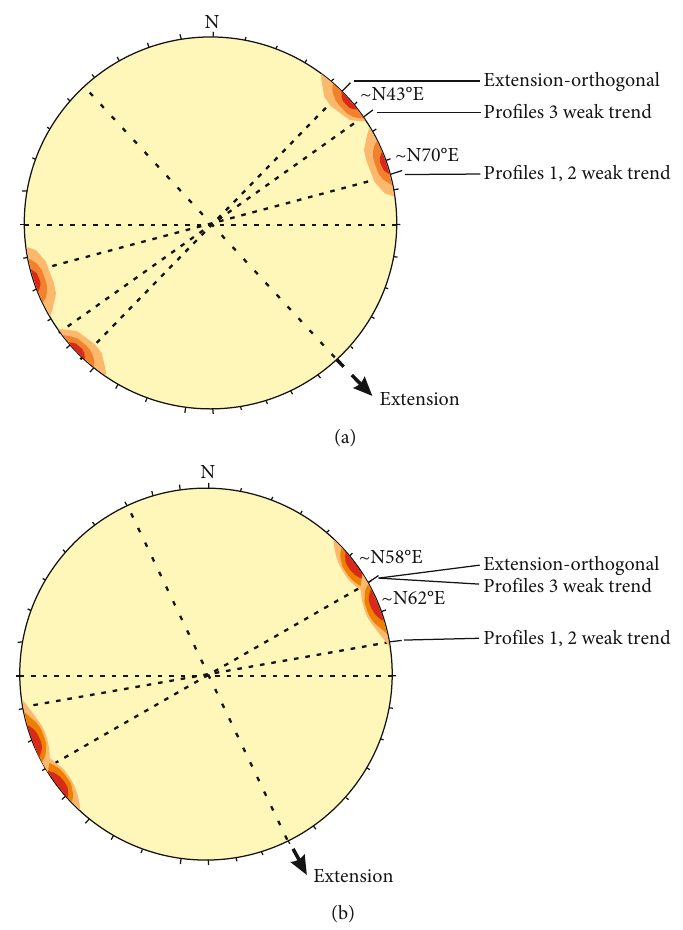
Figure 11: Rift zone fault dominant strike orientation map for the reference model and model